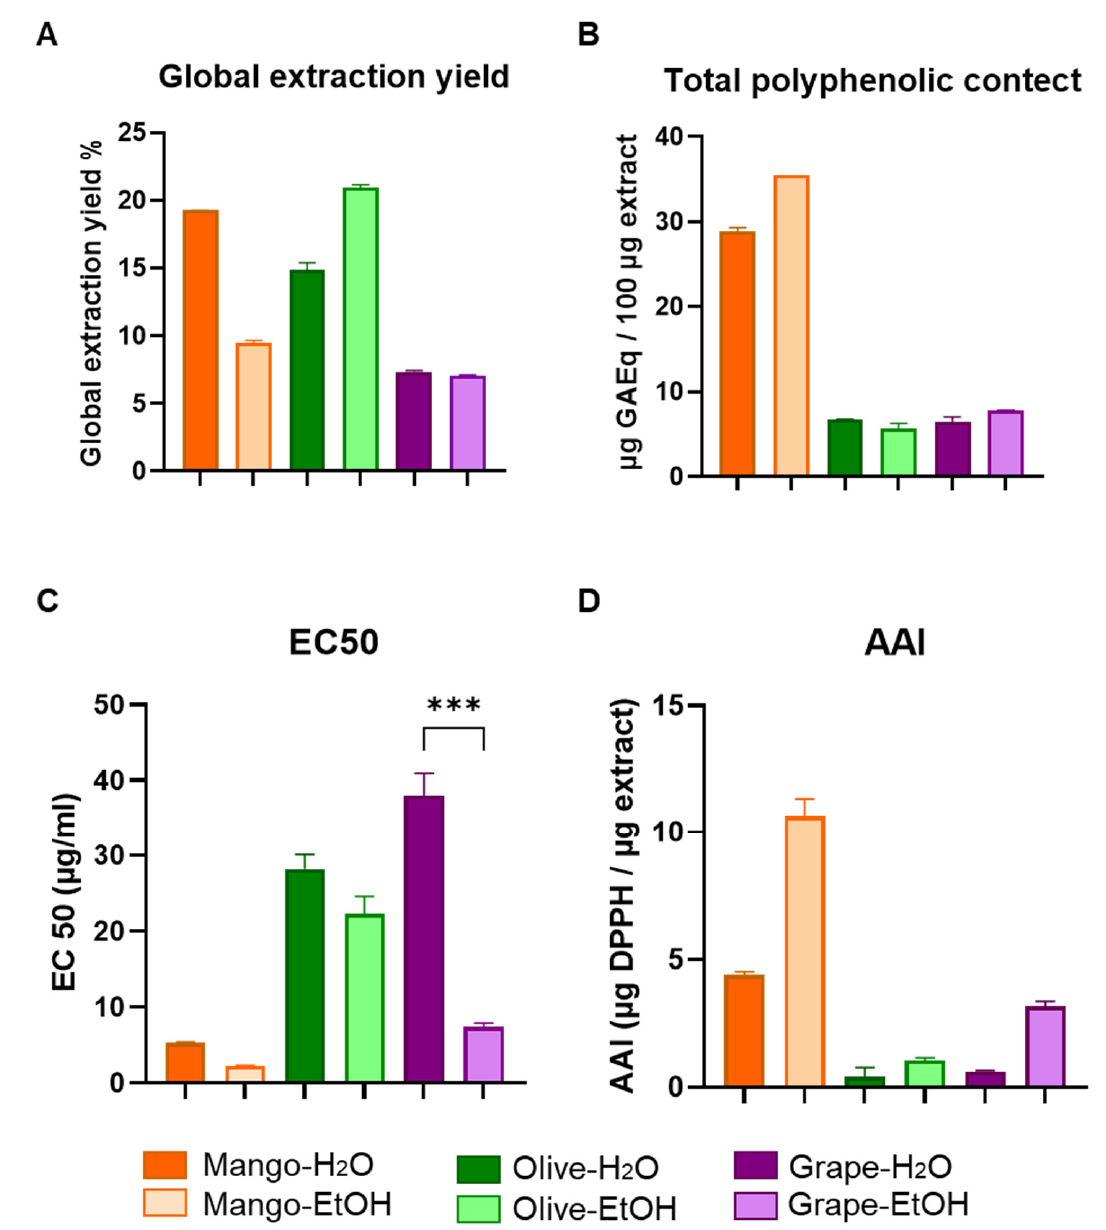
Figure 1. Chemical and functional characterization of the extracts obtained by PLE. ( A ) Graphical representation of global yield of the aqueous and ethanolic extracts of mango leaf, olive leaf, and red grape pomace expressed as g/100 g dry extract (%). ( B ) Total phenolic content expressed as g/100 g dry extract. ( C ) Antioxidant activity represented by the efficient concentration (EC 50 ) ( μ g/mL). ( D ) Antioxidant activity index (AAI) ( µ g DPPH/ µ g extract) . Values are represented as the mean ± SD. *** p -value < 0.001.